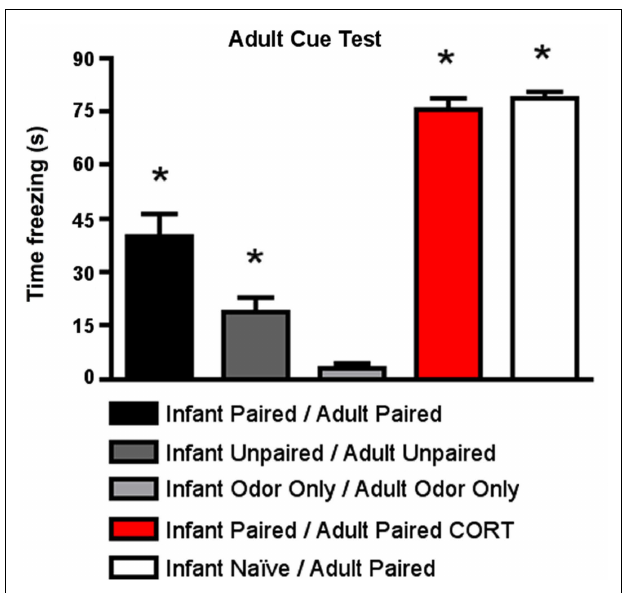
FIGURE 8 | RIA measurement from adult rats immediately following odor-shock conditioning indicates that CORT levels increased in Infant Naïve/Adult Paired groups ( n = 4–5/group) and control. The Infant Odor Only/Adult Odor Only group that did not receive shocks, show low levels of CORT. Asterisk represents a signifi cant difference from each of the other groups ( p <